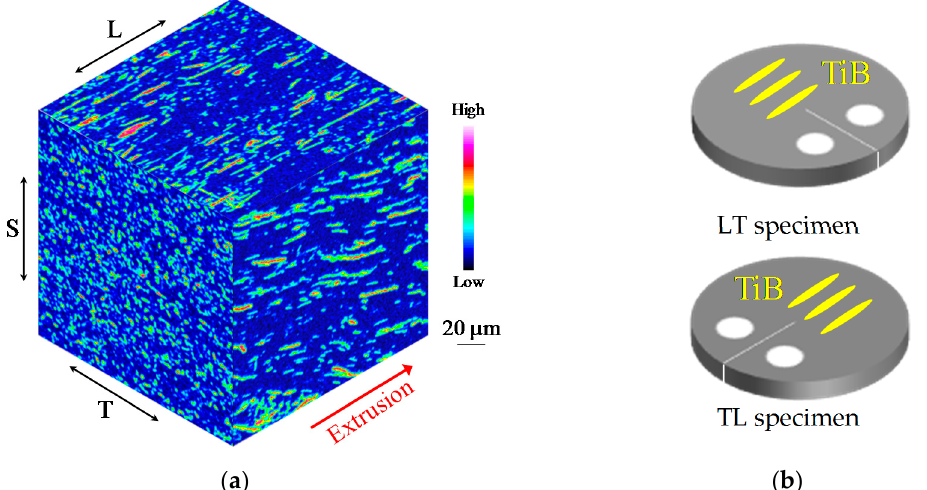
Bal. Table 2. Chemical composition of TiB 2 powder (mass%). B